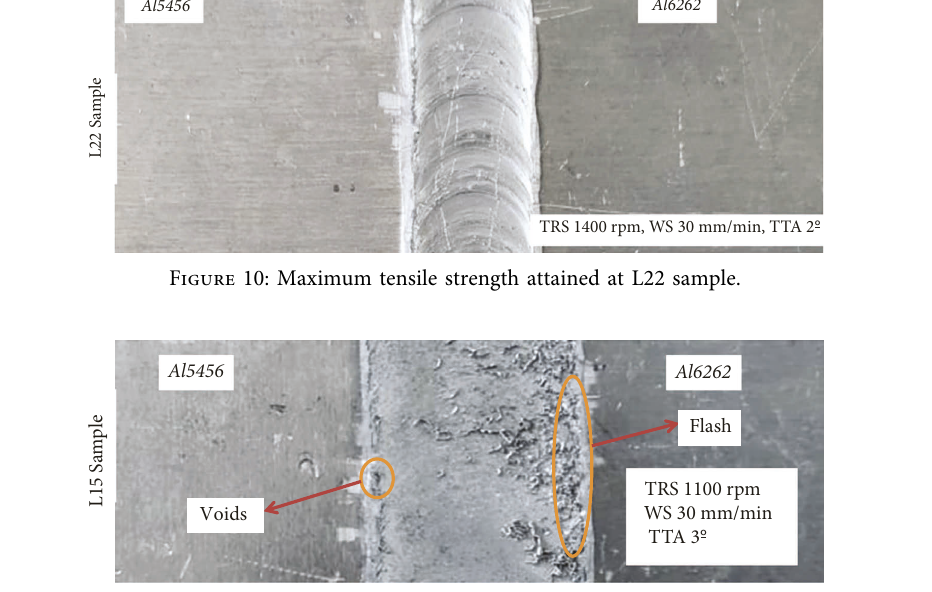
Figure 11: Minimum tensile strength attained at L15 sample. Table 5: Welding efficiency-tensile